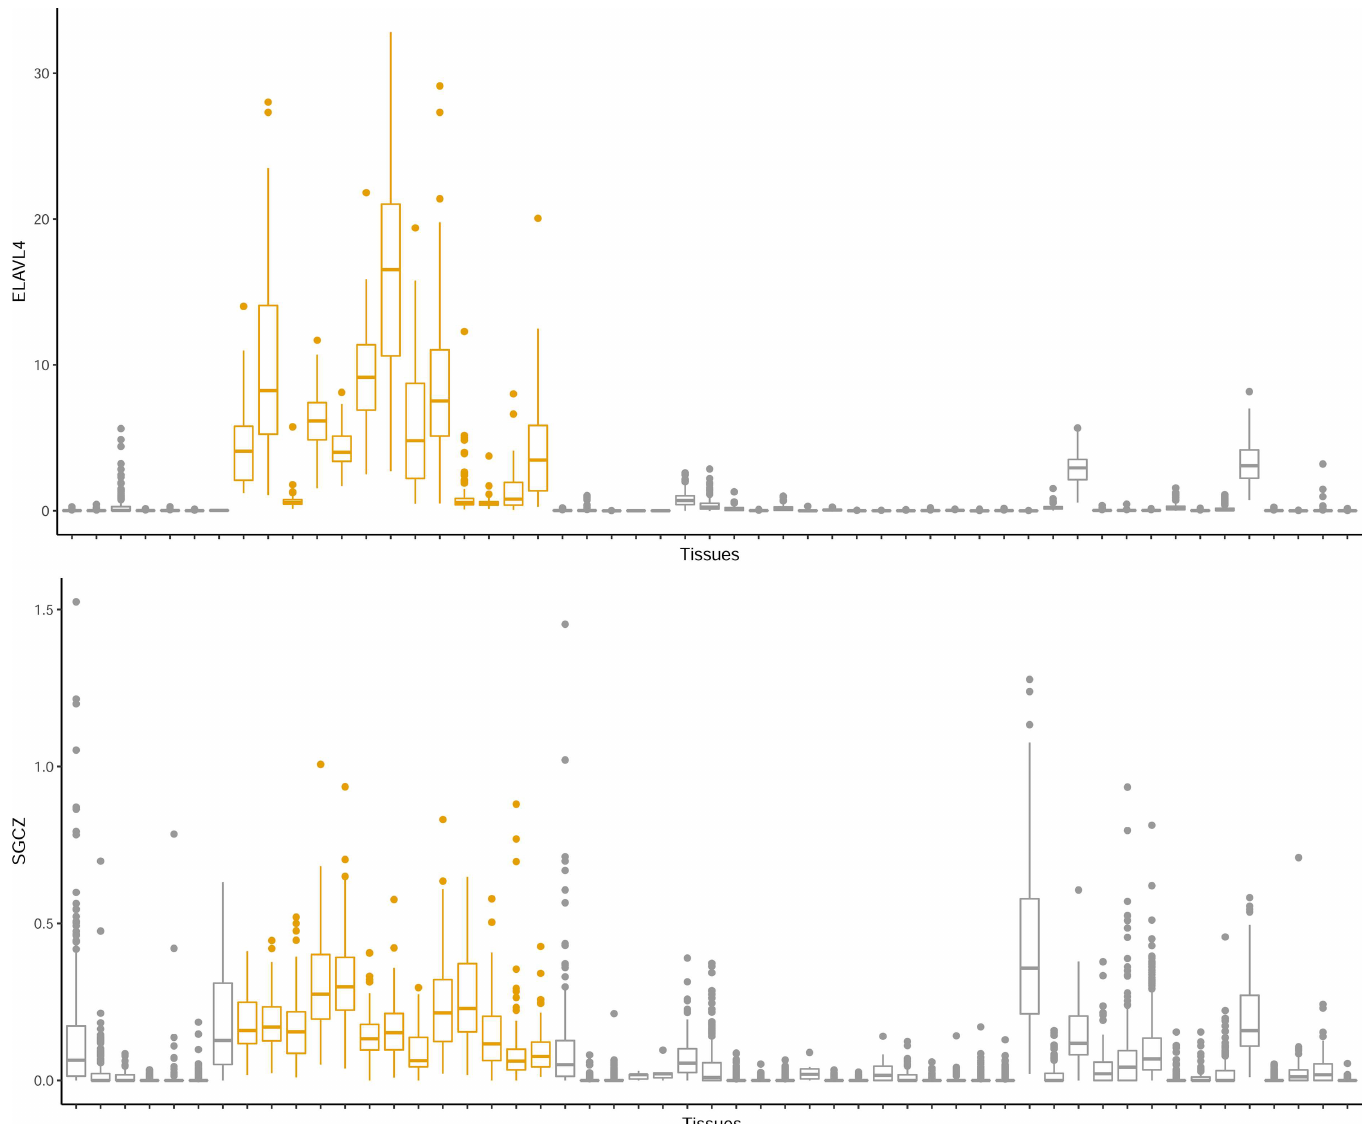
Fig 5. The gene expressions of ELAVL4 and SGCZ across different tissue in GTEx database. The bar shows the expressionmedianand interalquartile range in different tissues. The yellow bars repsent tissues in